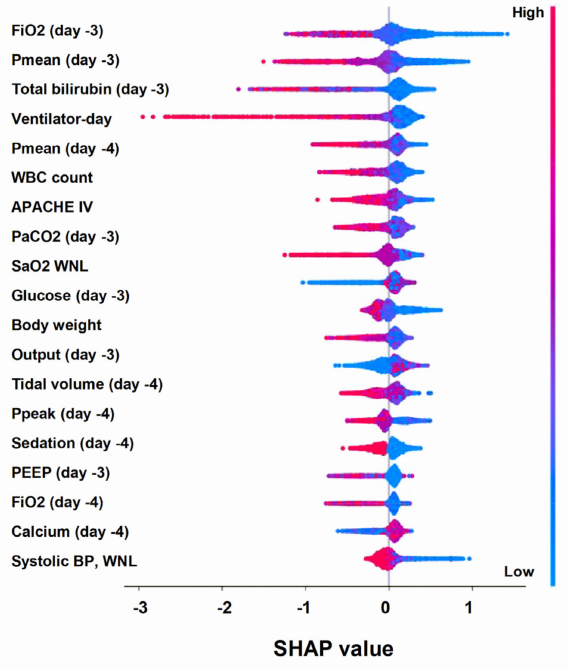
Figure 4. SHAP to illustrate the one–year mortality prediction model at the feature level. Each point on the plot represented a Shapley value for one feature and subject. Abbreviation: SHapley Additive exPlanation (SHAP).